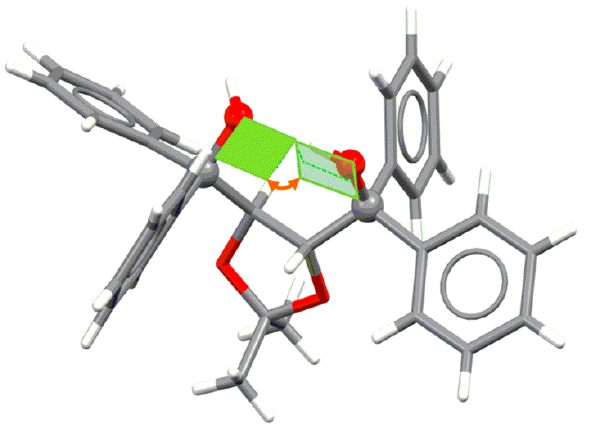
Figure 11. The definition of the C-O…O-C pseudo-torsion angle in TADDOL molecule.